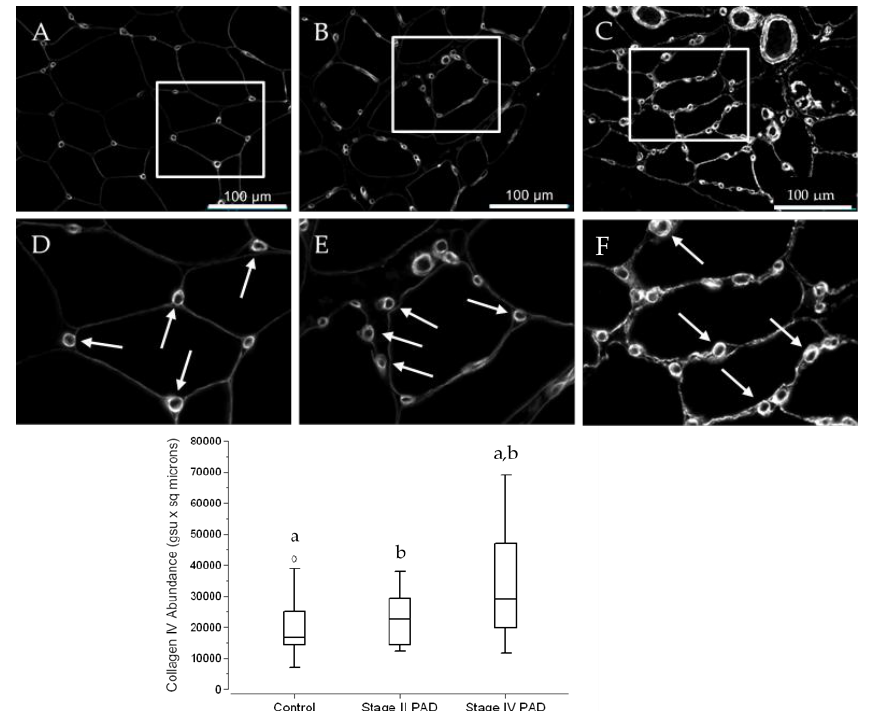
Figure 6. Collagen IV deposition presents as intensely labeled BM rings that delineate micro-vessels in the calf muscle of control subjects and PAD patients. Slide specimens of biopsies from calf muscle of control subjects ( A ) ( N = 14) and patients with Stage II ( B ) ( N = 15) and Stage IV ( C ) ( N = 16) PAD were labeled with anti-Collagen IV antibody, and fluorescence images were captured with a widefield